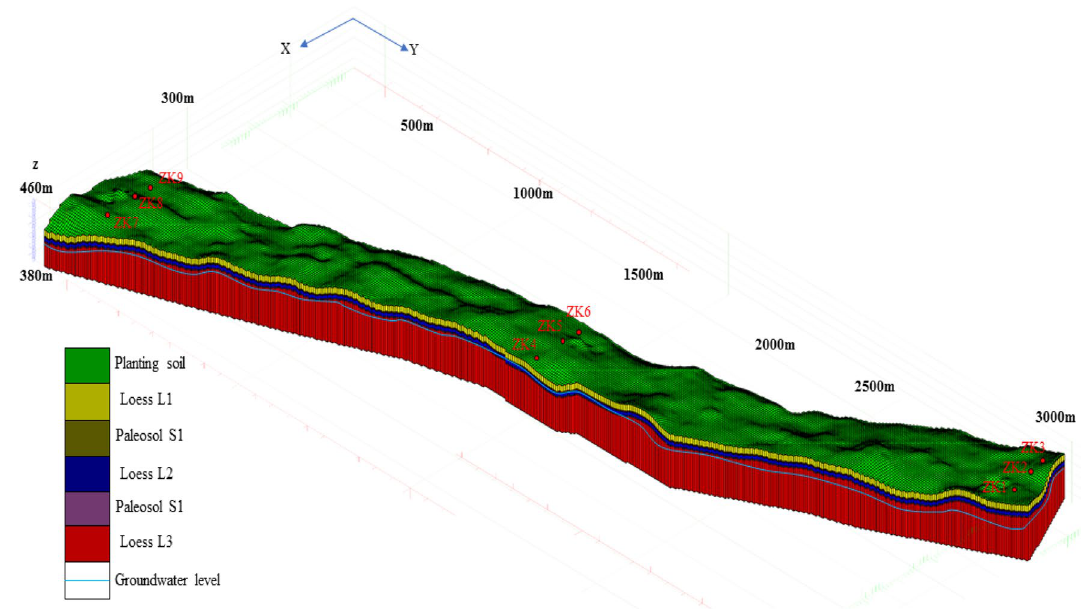
Figure 15. 3D geological